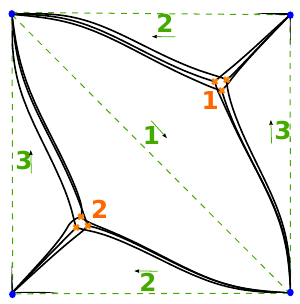
= 0 . Middle left: a spectral network associated to the 3 described in the main text. Middle right and far right: two 3